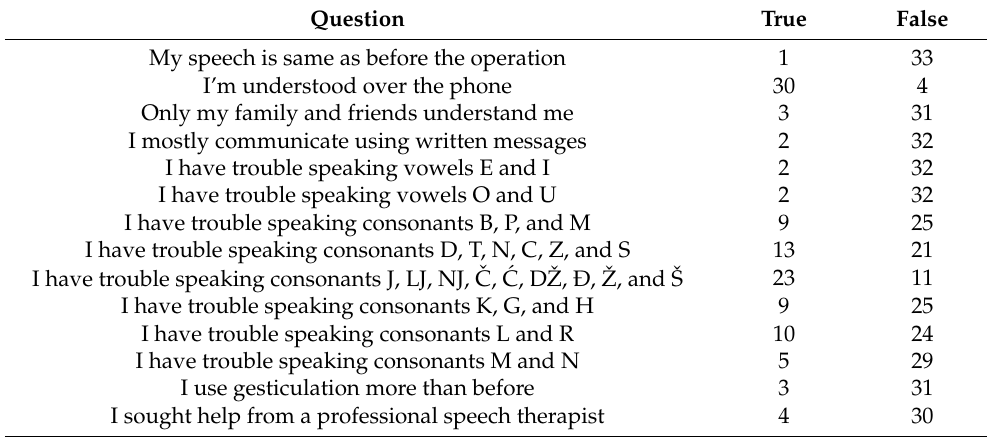
Table 2. Speech impairments of the study